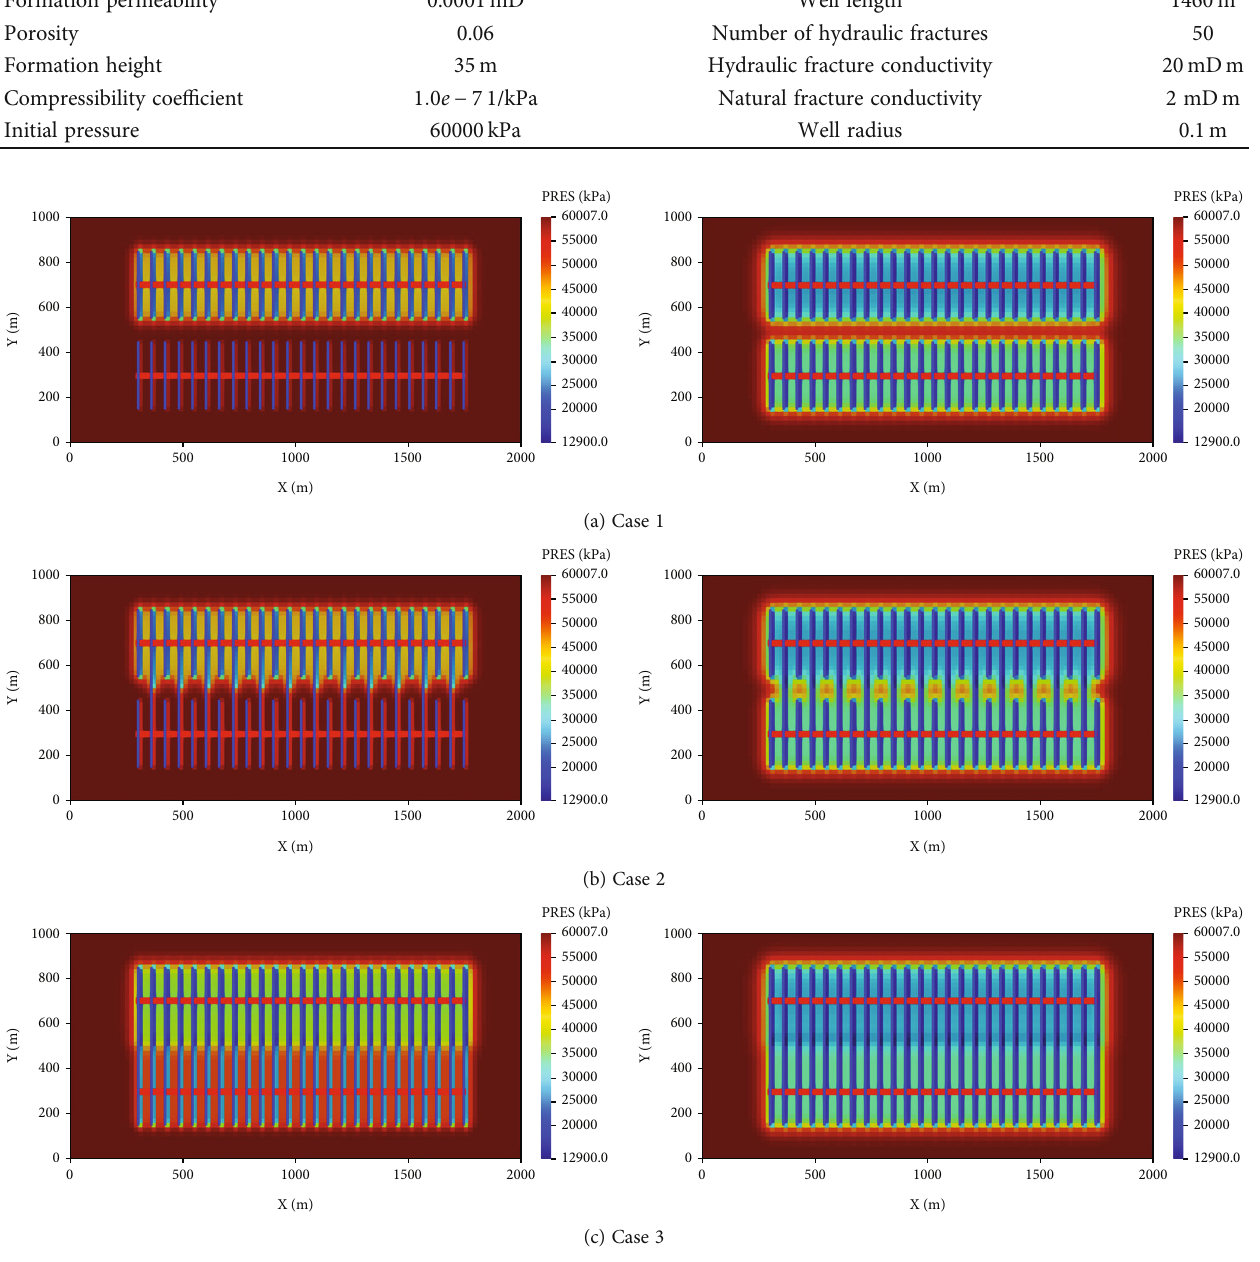
Figure 3: Pressure distribution of two MFHWs considering only hydraulic fractures in di ff erent time steps. (a) Two horizontal wells are not directly connected. (b) Two horizontal wells are connected through partial hydraulic fractures. (c) Two horizontal wells are connected through all hydraulic